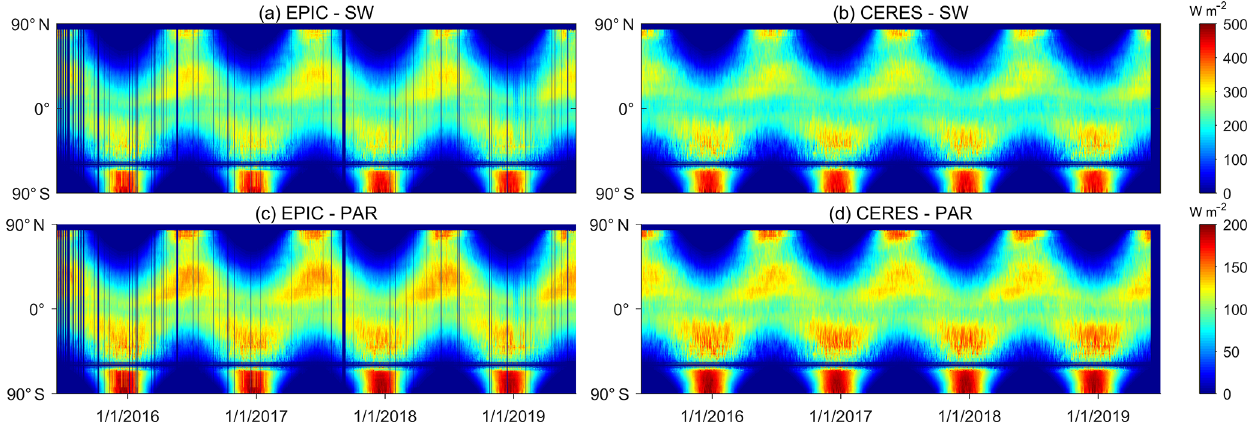
Figure 11. Temporal variations in (a, c) EPIC- and (b, d) CERES-based zonally averaged daily total (a, b) SW and (c, d) PAR for global land areas. The vertical dark bars in (a, c) are due to the missing